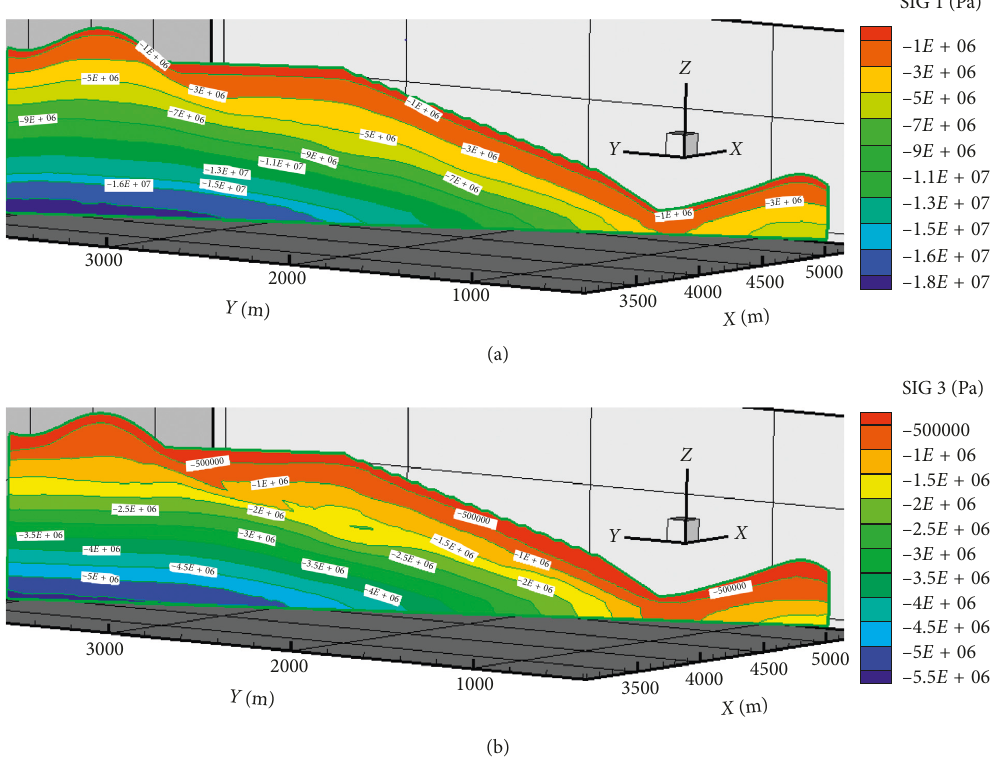
Figure 8: Section view of principle stress isoline at step 8. (a) Isoline graph of maximum principle stress. (b) Isoline graph of minimum principle